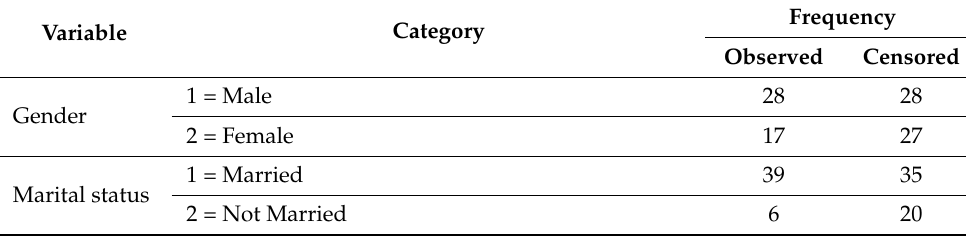
Table 6. Frequency distribution of categorical variables in rice farmers’